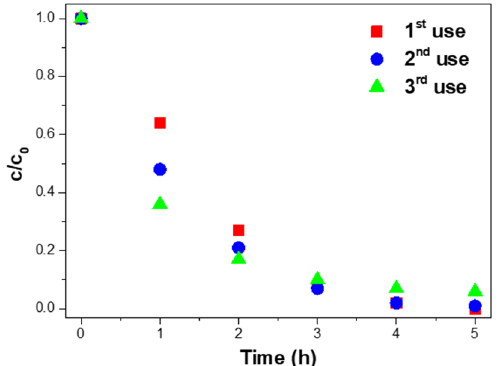
Figure 7. Photocatalytic degradation of MNZ (10 mg/L) with 10% Ag@TiO 2 /PVDF–HFP membranes in three consecutive uses, under 5 h of sunlight exposure in each experiment.